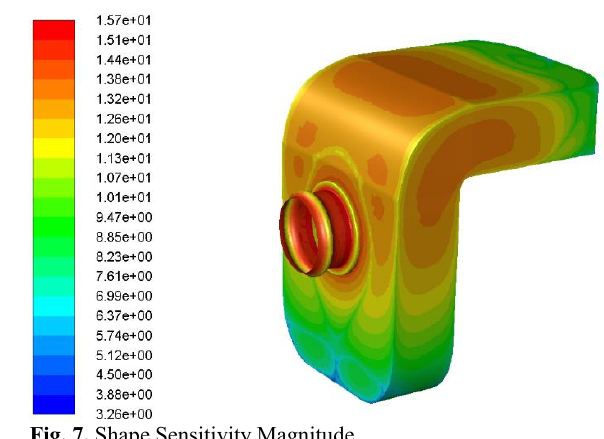
Fig. 7. Shape Sensitivity Magnitude